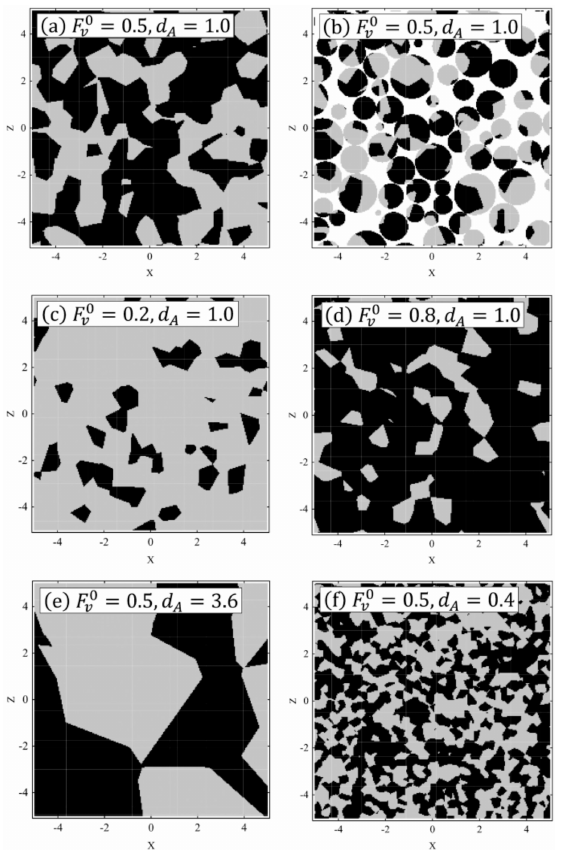
Figure 4. Partial sectional images of the binary structure created by the Voronoi model: ( a ) phase A volume fraction ( F 0 v ) = 0.5, phase A element diameter ( d A ) = 1.0; ( b ) after particle hollowing of ( a ); ( c ) F 0 v = 0.2, d A = 1.0; ( d ) F 0 v = 0.8, d A = 1.0; ( e ) F 0 v = 0.5, d A = 3.6; and ( f ) F 0 v = 0.5, d A =